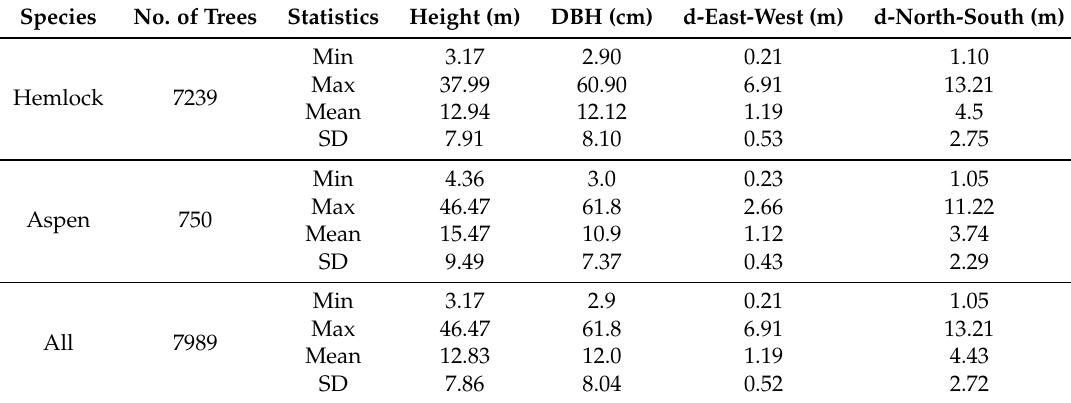
Table 1. Statistics for the Howland stem map collected in 2010. Min is the minimum value, Max is the maximum value, Mean is the averaged value, and SD is the standard